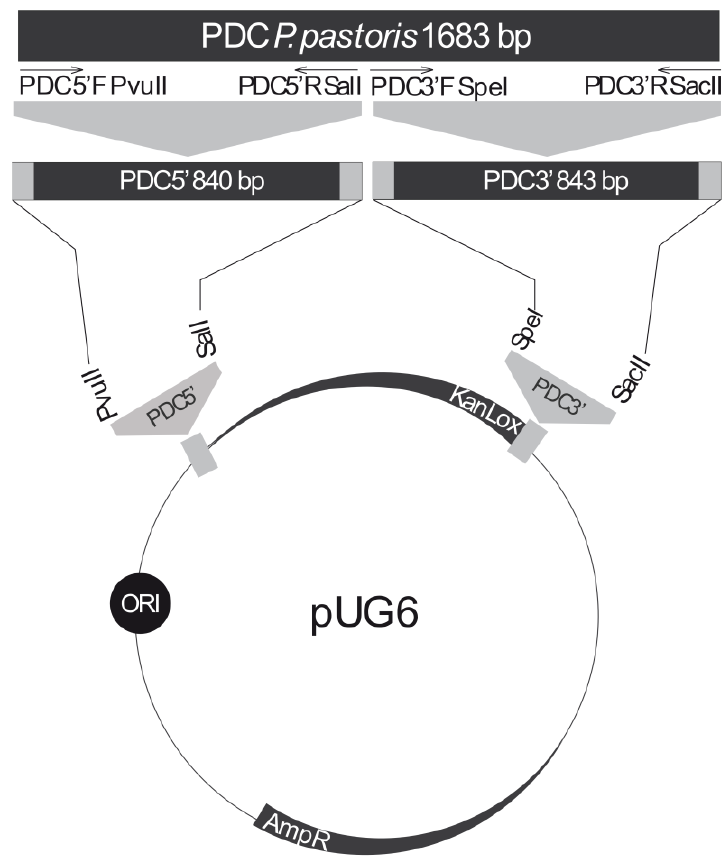
Figure 1. Construction of PDC knockout cassette. The entire PDC-encoding gene has 1683 bp. This was divided into two fragments of 840 and 843 bp. Each fragment was cloned into the pUG6 plasmid flanking the Kanamycin resistance cassette with the indicated restriction enzymes. Final cassette has a total of 3317 Kb. Table 2. Primers used in this study. Sequences of restriction enzymes are highlighted in bold.